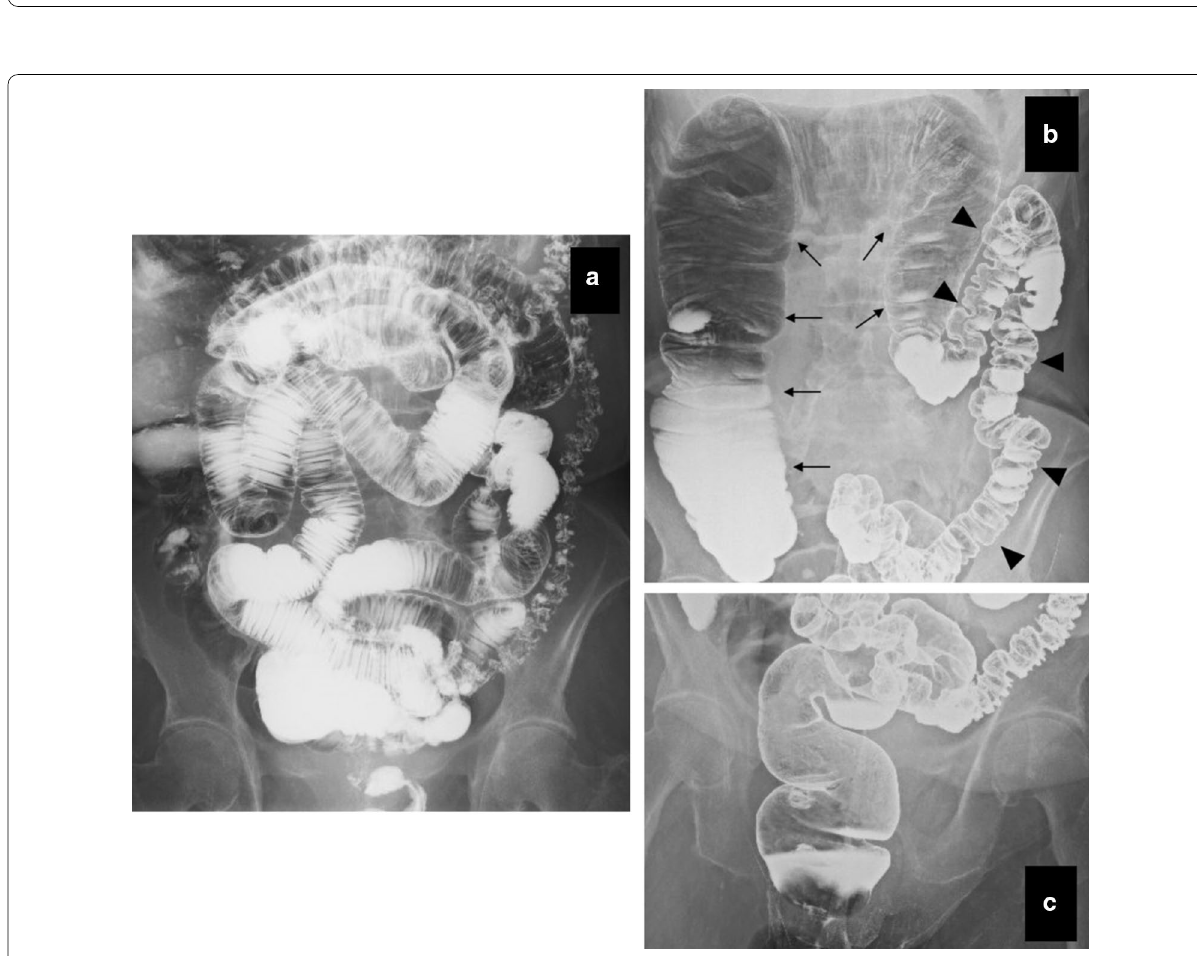
Fig. 3 Enteroclysis and barium enema. a No stricture, enlargement, or functional decline seen in the small intestine. b , c The rectum is not dilated; the dilated right-side colon (arrow) and the collapsed left-side colon (arrowhead) are seen with barium